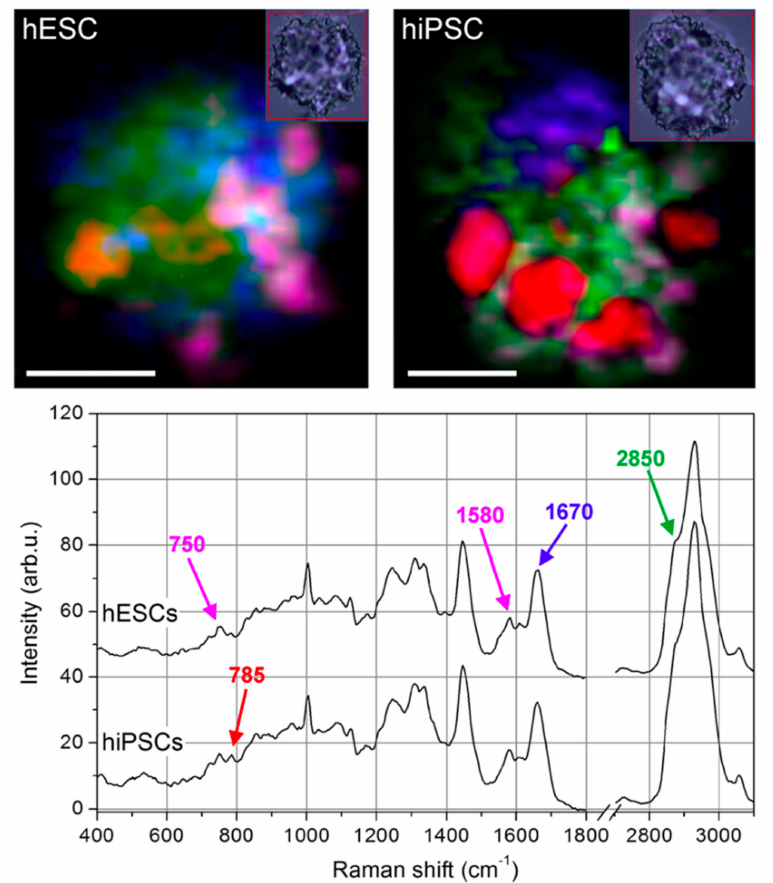
Figure 4. Raman imaging of typical human Embryonic Stem Cells (ESCs) and Induced Pluripotent Stem Cells (iPSCs). Colour-reconstituted Raman images of human embryonic stem cells (hESCs, upper left panel) and human induced pluripotent stem cells (hiPSCs) (upper right panel). White scale bar = 5 µ m. Small insets show corresponding bright-field images recorded after Raman scanning. Raman peak at 785 cm –1 (DNA / RNA bases) mapped in red, 1670 cm –1 (proteins) in blue, 2850 cm –1 (lipids) in green, and a combination of 748 and 1585 cm − 1 (cytochrome C) in magenta. hiPSCs exhibit a much higher level of DNA / RNA bases in well-defined regions of the cell. Curves in the lower panel are average spectra of hESCs (top curve) and hiPSCs (bottom curve), where the peaks used for the colour-reconstituted images are indicated with the corresponding colour (Reproduced from Parrotta et al. [95] under Creative Commons CC BY